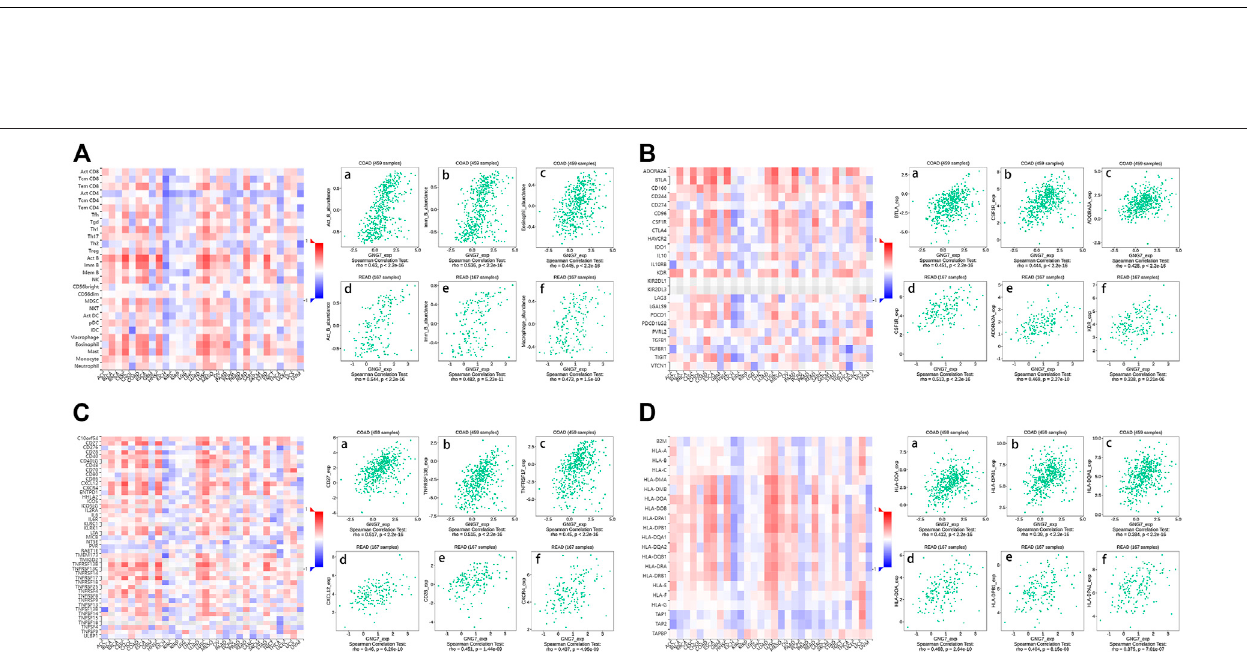
Frontiers in Genetics |